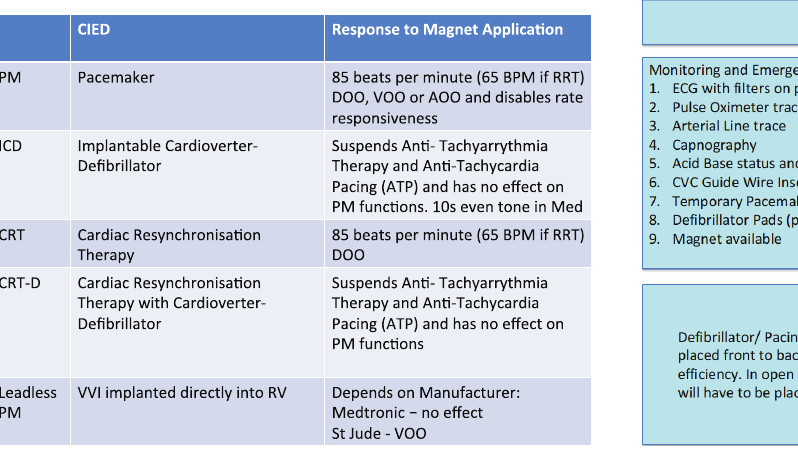
Figure 5: Response to magnet application in Medtronic PM and ICDs